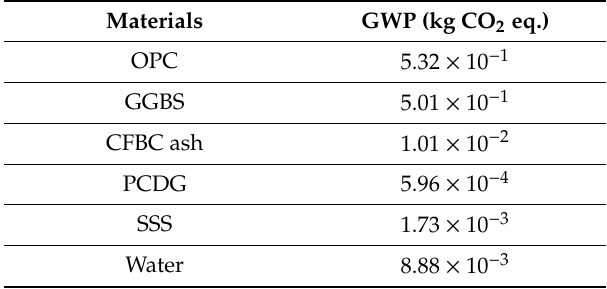
Table 6. Characterized environmental impacts index of materials used.